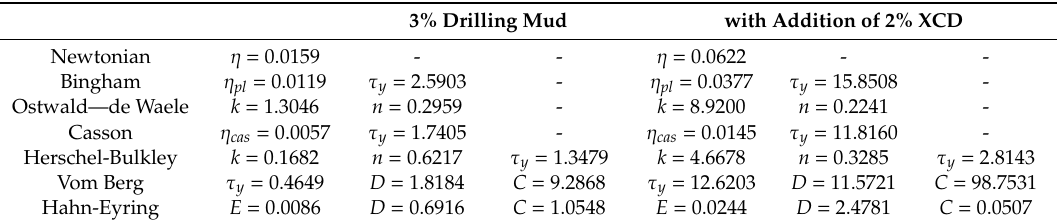
Table 4. Fluid rheological parameters obtained from Rheosolution 4.0 for drilling mud samples (with and without adding polymer).